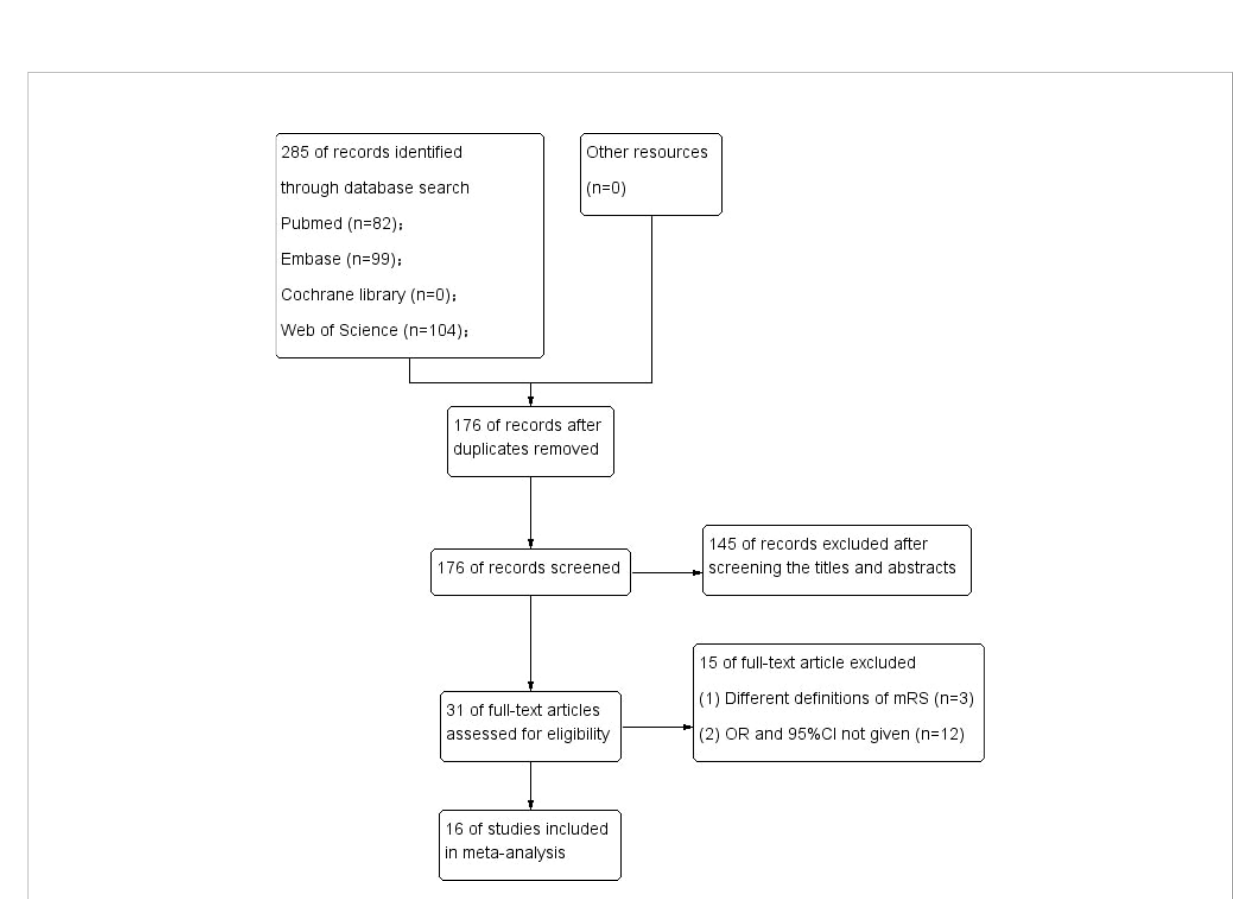
FIGURE 3 Flow diagram of study